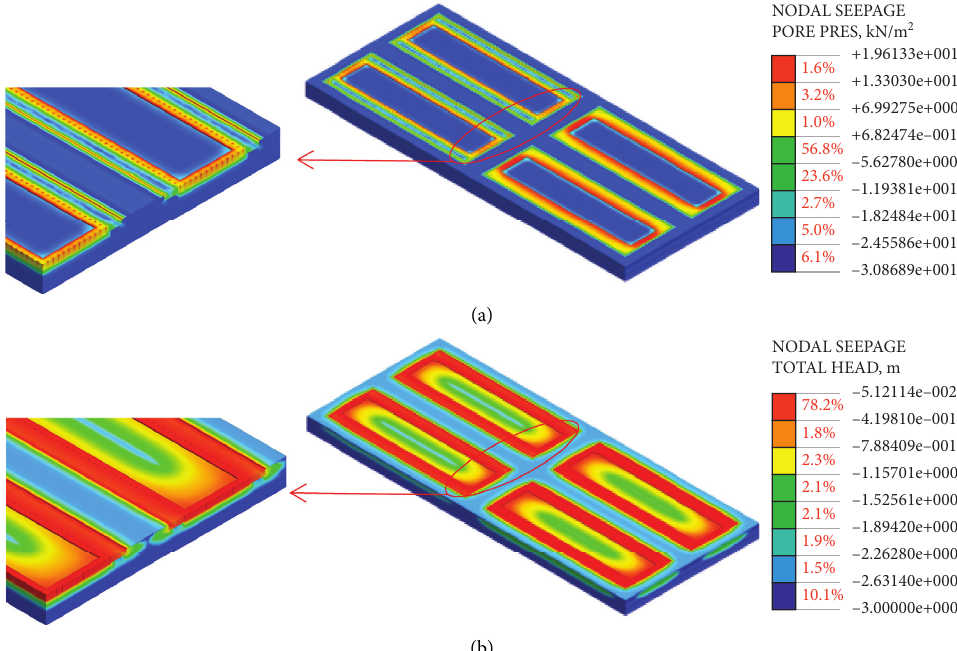
Figure 29: Total head nephograms of buildings with seepage wells placed around buildings 1 and 2 after (a) 10min and (b) 120min of rainfall in the numerical model (the color of the legend represents the total head